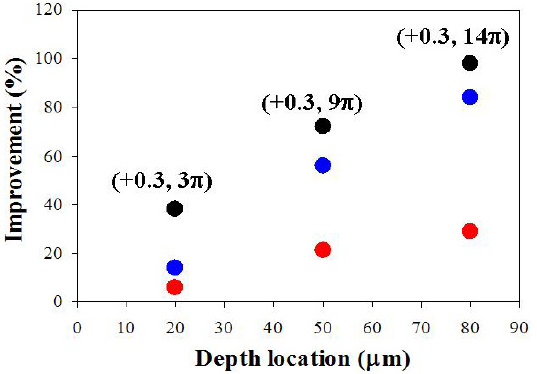
Figure 11. Comparison of MP signal improvement as a function of depth when using SA (red), axicon (blue), or an optimum combination of both (white).